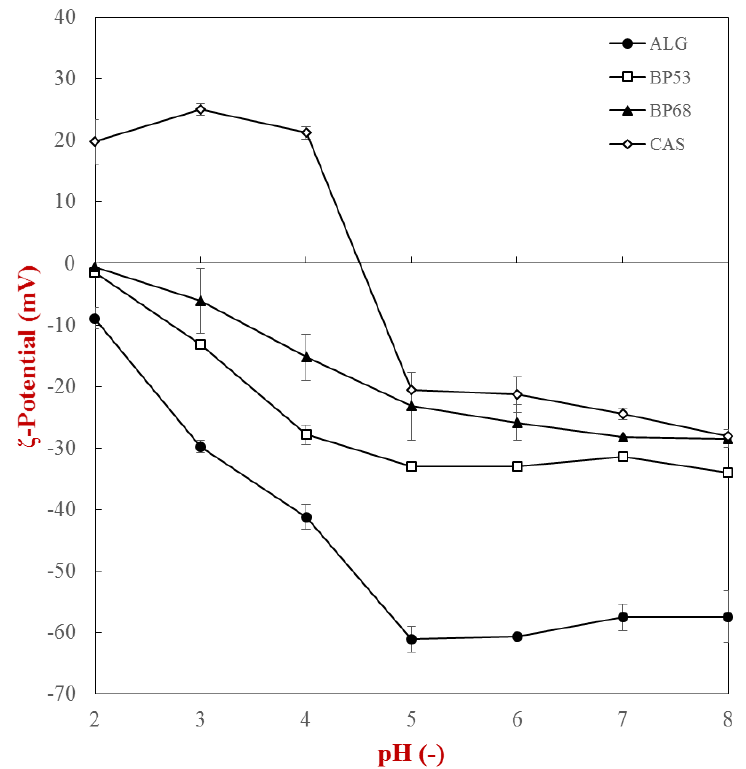
Figure 1. ζ -potential of single biopolymer solutions ( c biopolymer = 0.1%) as a function of pH (2–8): caseinate (CAS), alginate (ALG), sugar beet pectin DE 53% (BP53), and sugar beet pectin DE 68% (BP68).